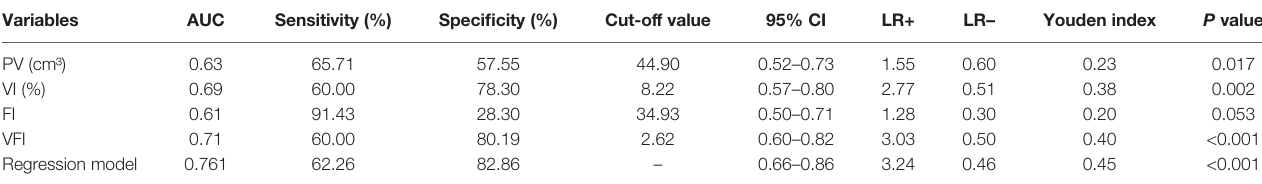
TABLE 4 | Diagnostic values of PV, VI, FI, and VFI for